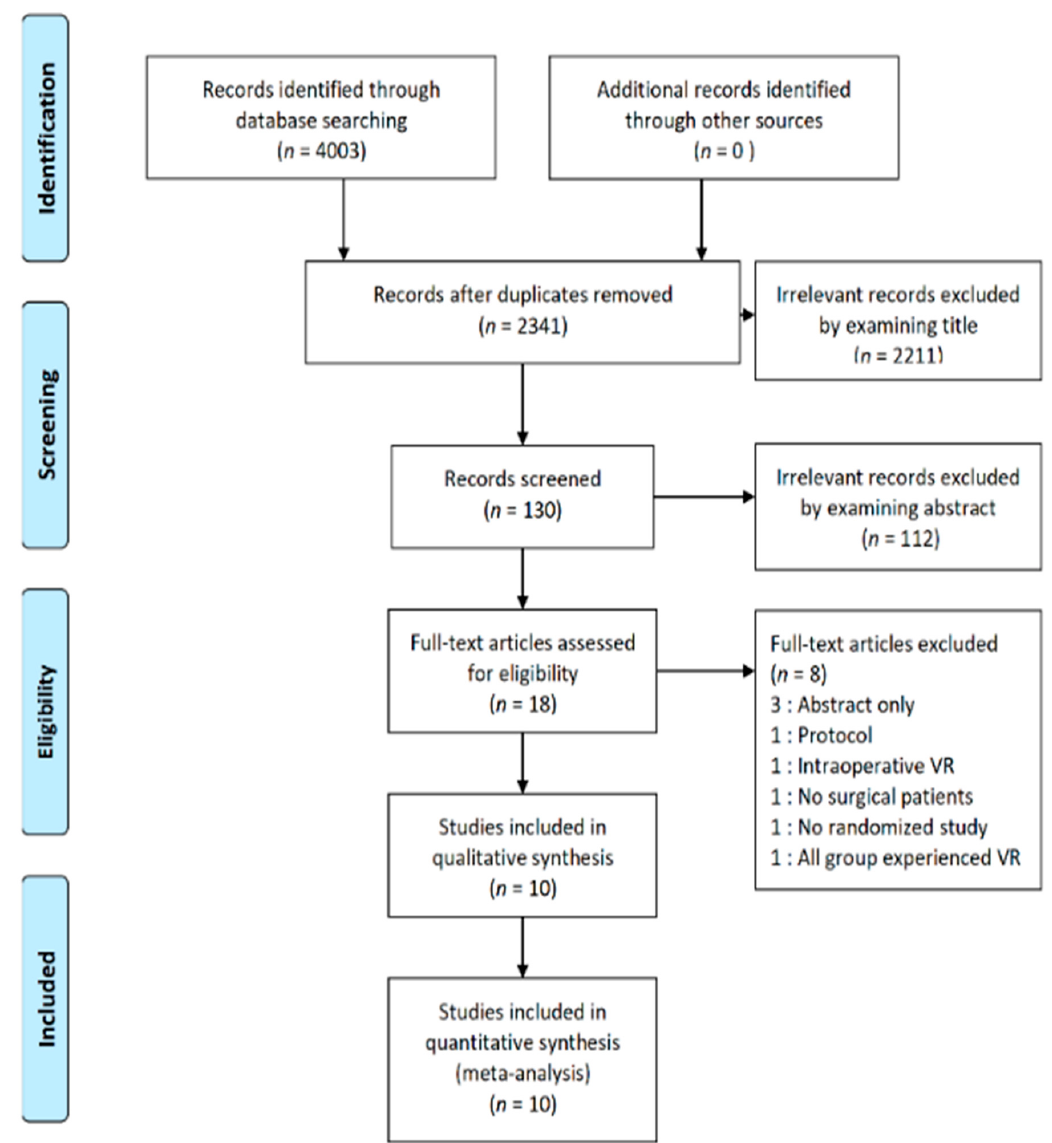
Figure 1. Flow diagram of included and excluded studies.